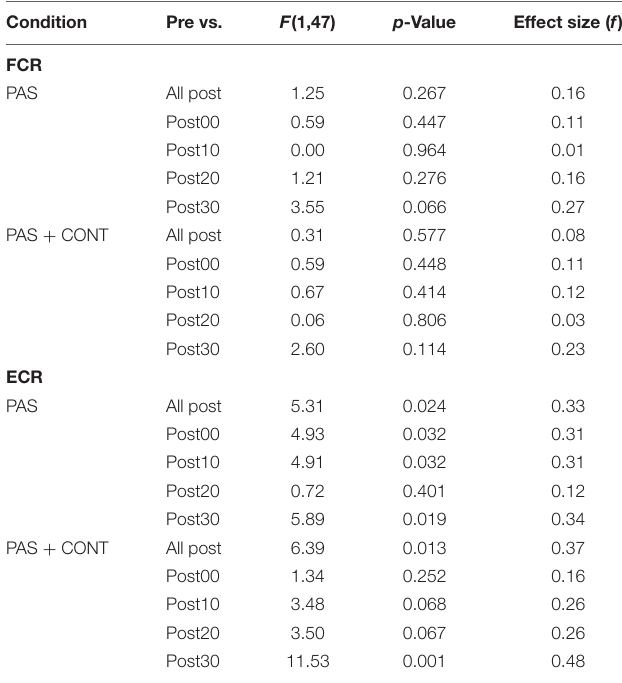
TABLE 4 | Older healthy participants: F ratios, p -values and (unbiased) effect sizes for comparisons between the MEP amplitudes obtained prior to the intervention (Pre), and (i) the pooled values obtained across all time points following the intervention, and (ii) the values obtained at each of four time points following the